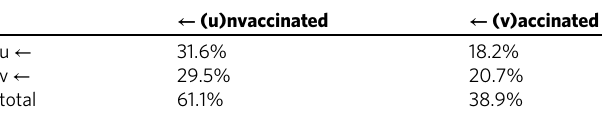
Table 4 Relative contributions to R from infections between vaccinated and unvaccinated groups for the “ low ef fi cacy ”